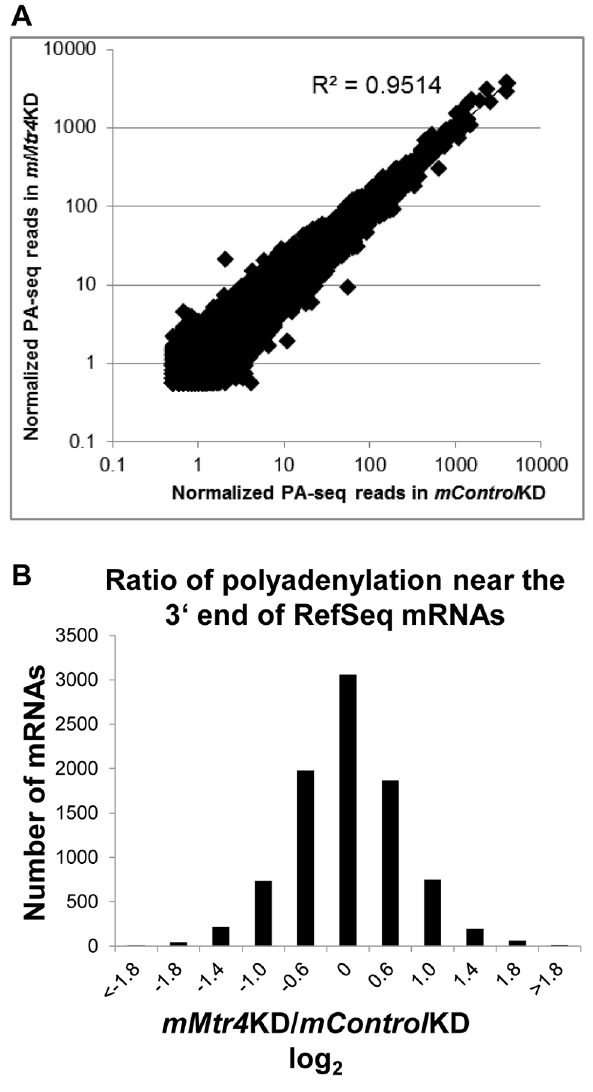
Figure 2. Knockdown of mMtr4 does not significantly alter polyadenylation of protein coding mRNAs. 2A ). Dot Plot of PA- seq data from the mMtr4 KD versus mControl KD for 8,935 protein coding RefSeq genes. 2B ). Histogram reporting log 2 transformed ratios of mMtr4 KD/control reads. A value of 0 equals no difference, + 1 equals a two-fold difference, + 2 equals a four-fold difference, and positive values indicate that polyadenylated transcripts are more abundant in mMtr4 KD, whereas negative values indicate that they are more abundant in the mControl KD. The bin labeled 0 includes log 2 ratios ranging from + 0.2; all other bins include values expanding by + 0.4 in either direction, and labeled according to the outer boundary of that bin relative to